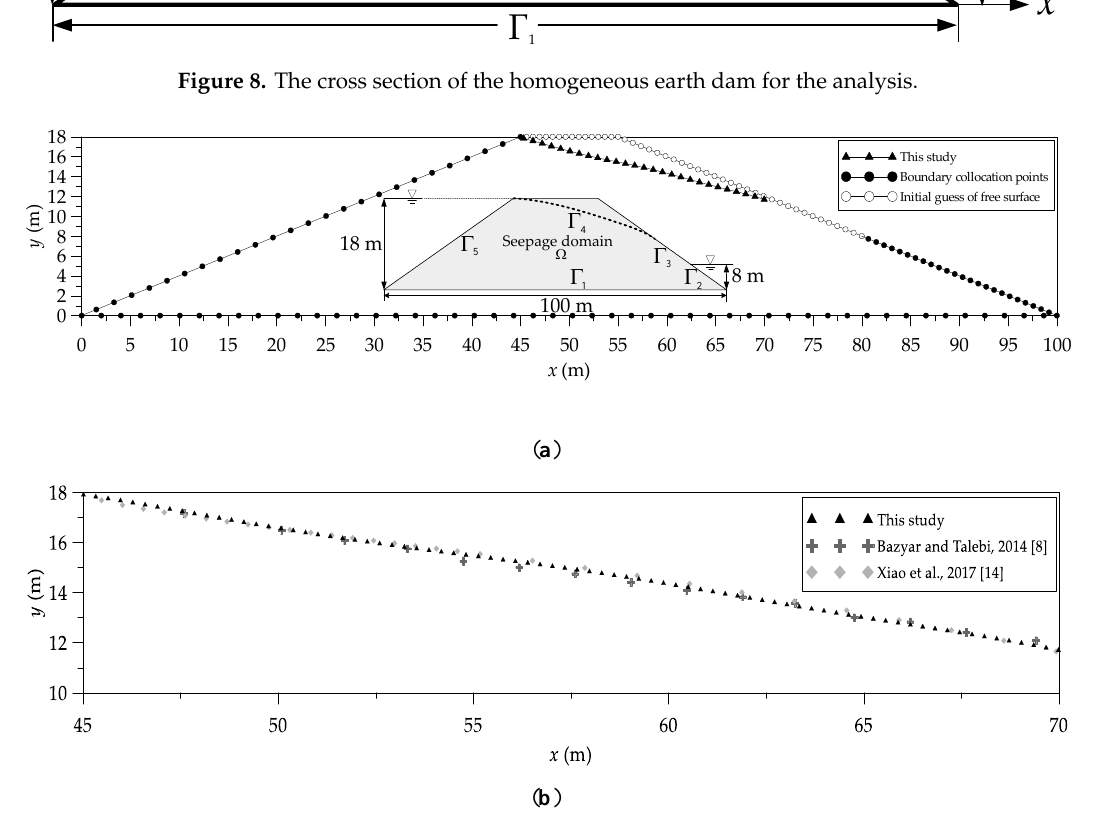
Figure 9. Free surface flow through a homogeneous dam. ( a ) Initial guess and the computed free surface and ( b ) comparison of the results with those from other methods.